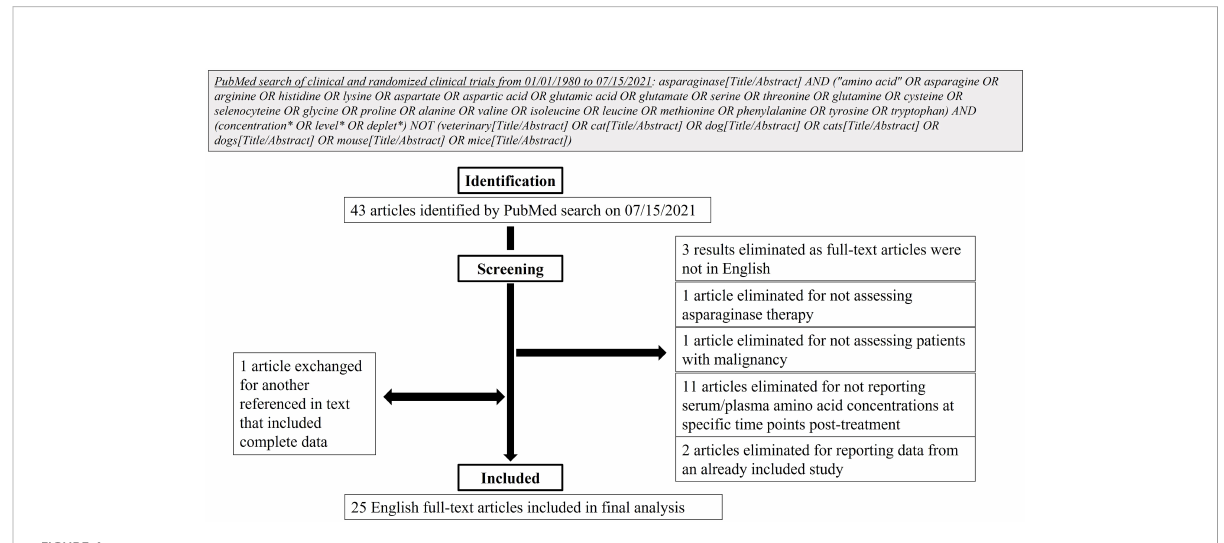
FIGURE 4 Flow diagram of literature search design and